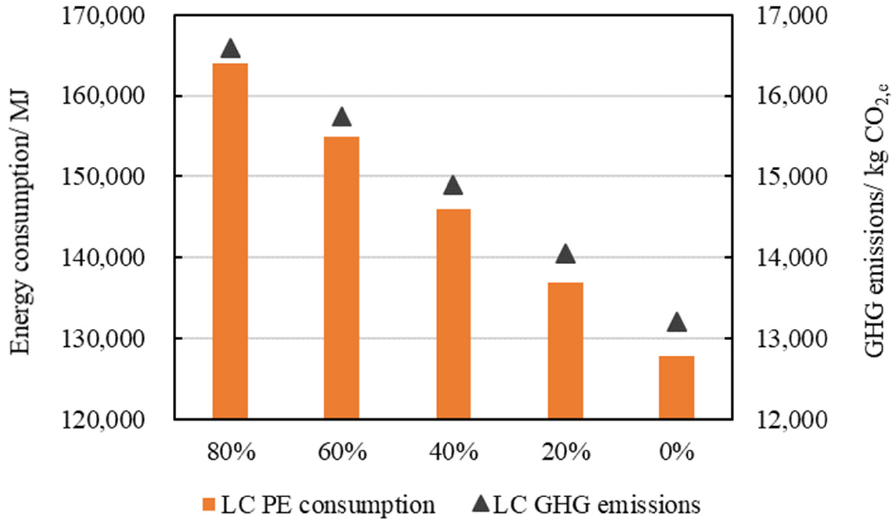
Figure 6. LC PE and GHG emissions intensities under different proportions of self-generated electricity in the electrolytic aluminum industry.